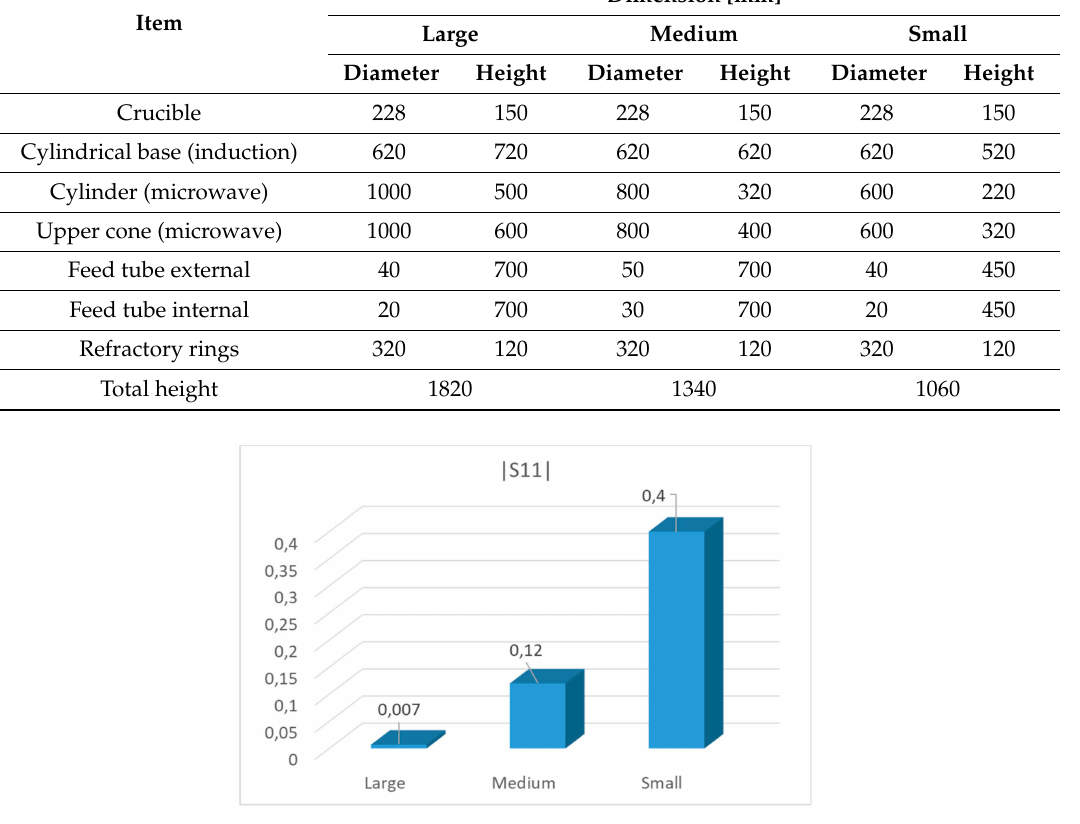
Figure 4. | S11 | for 3 di ff erent cavity dimension indicated in Table